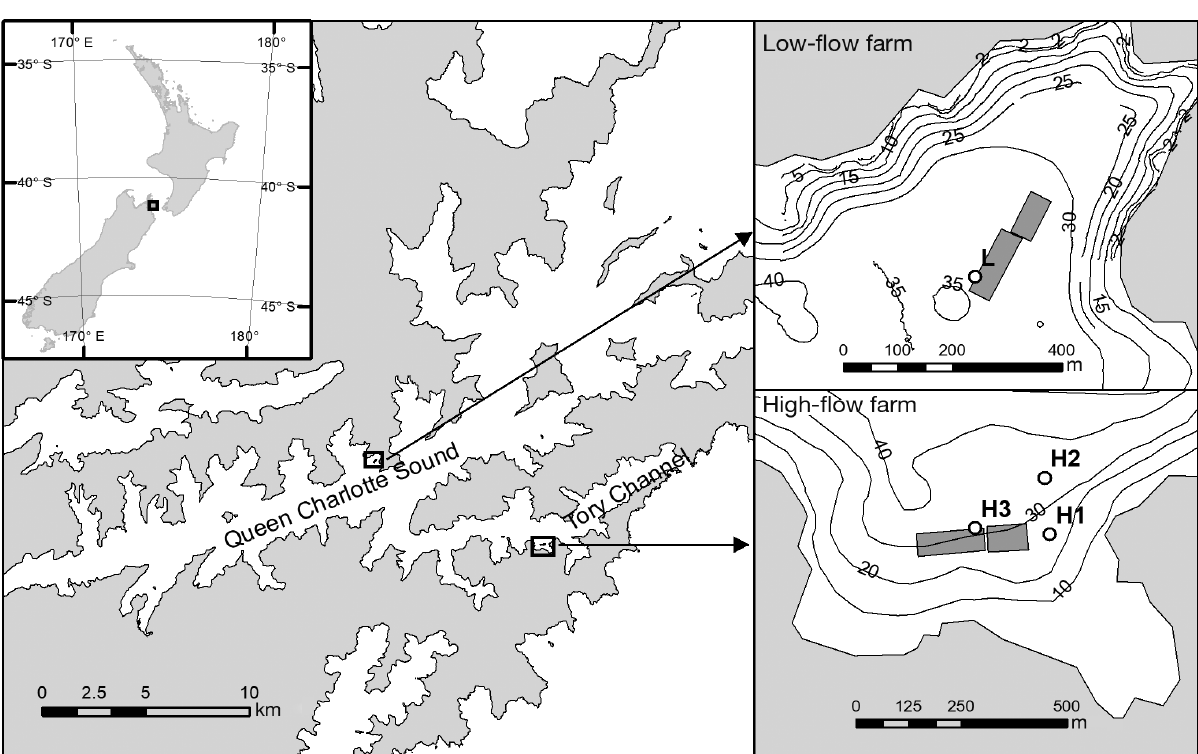
Fig. 1. Location of the 2 study sites and the EC systems in the Marlborough Sounds in New Zealand. The high-flow site is in the strongly tidal Tory Channel, while the low-flow site is in an embayment in Queen Charlotte Sound. Grey boxes are the fish